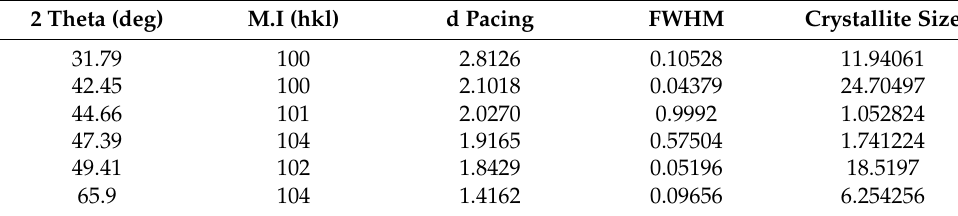
Table 2. XRD Diffraction Pattern of Mn NPs.